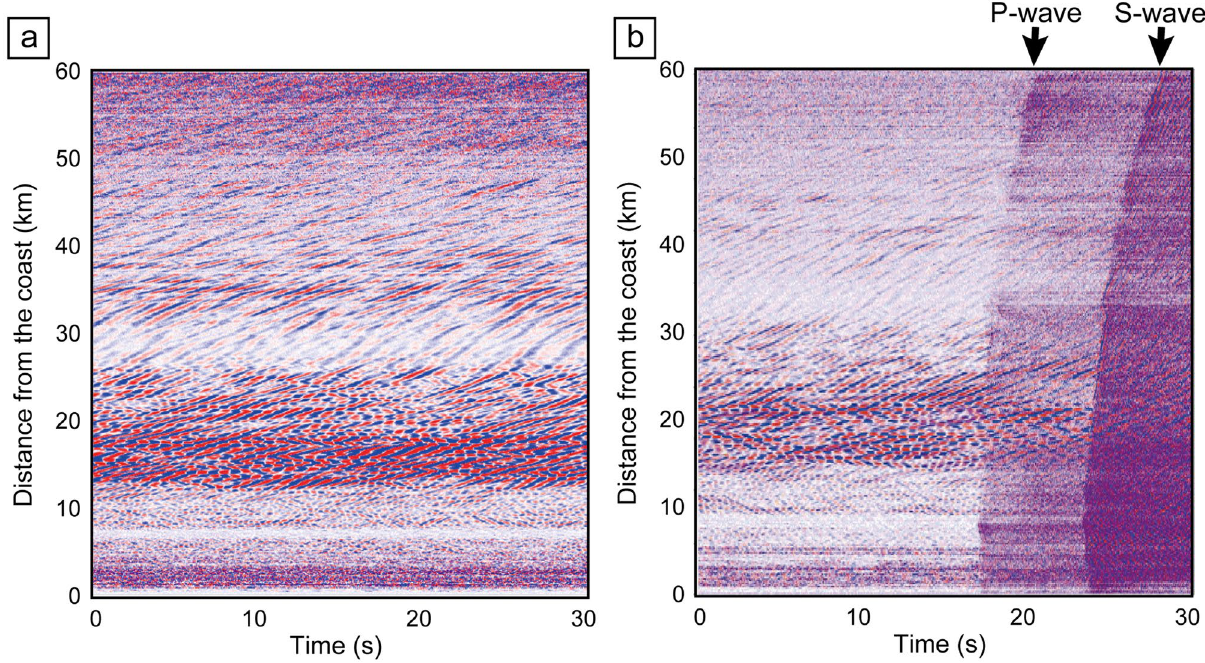
Figure 6. Ambient noise and natural earthquake records by DAS for seafloor fiber-optic cable. Here we displayed 6000 traces with 10 m channel interval. ( a ) Continuous record without the earthquake. ( b ) Continuous DAS record with the earthquake. P-wave and S-wave during the earthquake were clearly recorded at all channels (6000 traces). We clearly observed the noise related to ocean dynamics from 10 to 30 km distance. The location and intensity of the noise is temporarily